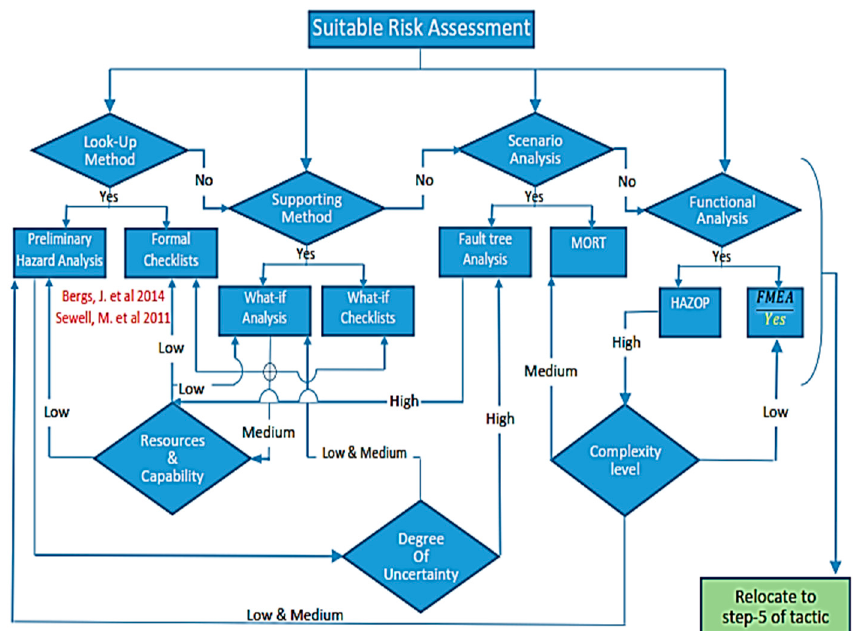
Appl. Sci. 2020 , 10 , x FOR PEER REVIEW Figure 4. Select suitable risk assessment to risk investigation. Figure 4. Select suitable risk assessment to risk investigation.